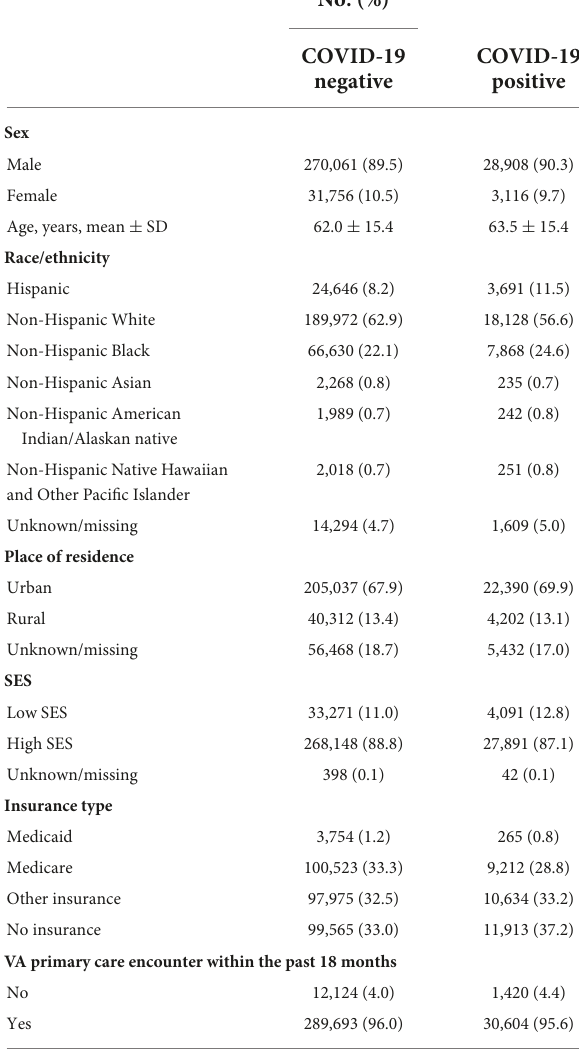
TABLE 2 Subject characteristics by COVID-19 test status ( n = 333,841 subjects).